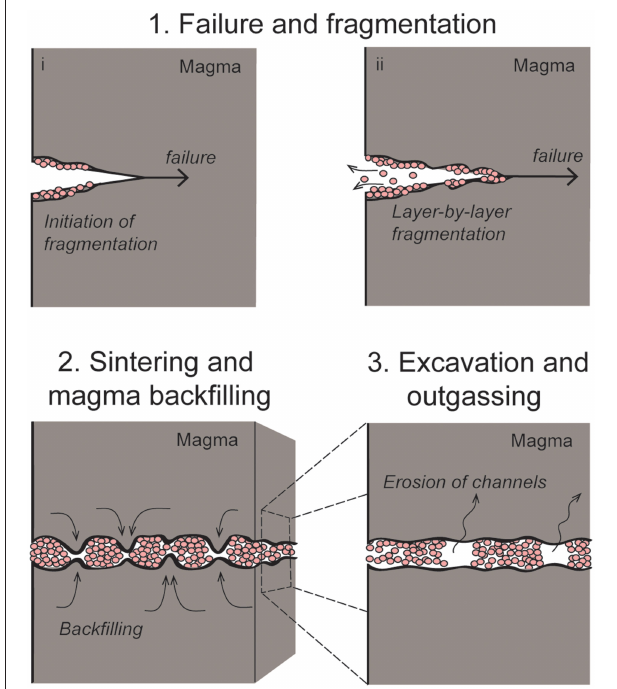
FIGURE 8 | A cartoon of the 3-stage process of tuffisite generation, characterized by an initial stage of: (1) failure and fragmentation, in which (i) the magma rips apart, forming particulate material (pale pink circles) and (ii) the fragmentation horizon migrates, extending the damage zone, and fragmenting material layer-by-layer; (2) the pyroclastic material is deposited in fractures, sometimes preserving the fragmentation horizons, the material relaxes, and sinters and magma backfills into voids left in the tuffisite and finally; (3) some fragmental material is excavated, creating channels that are thought to be important outgassing